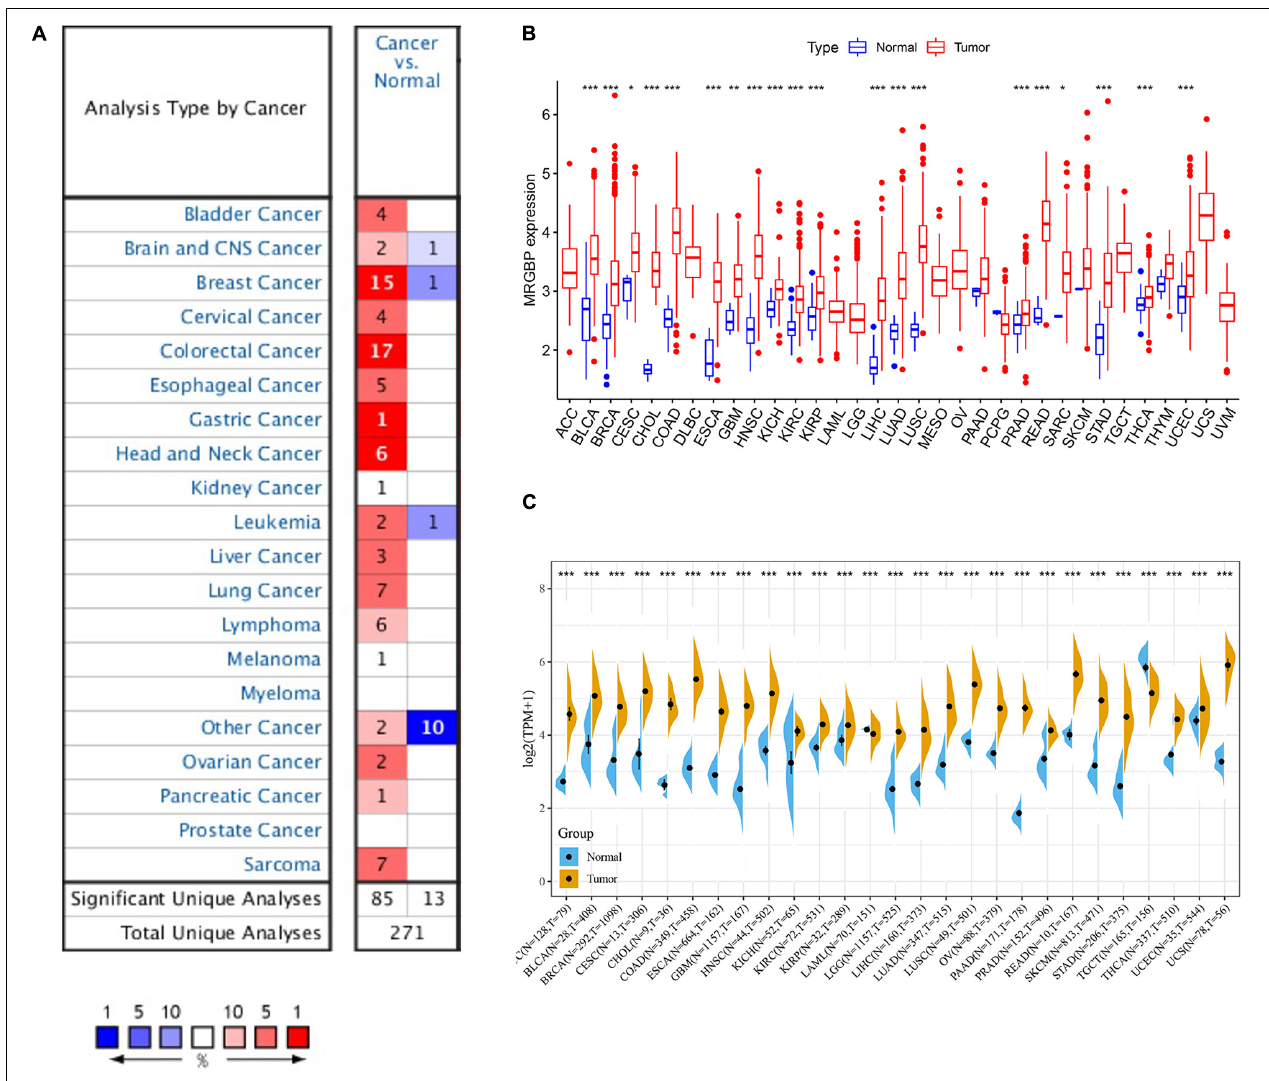
FIGURE 1 | mRNA expression of MRGBP gene in various cancers and its corresponding normal tissues. (A) Oncomine dataset. (B) TCGA dataset. (C) TCGA and GTEx dataset (*** P < 0.001, ** P < 0.01, * P <